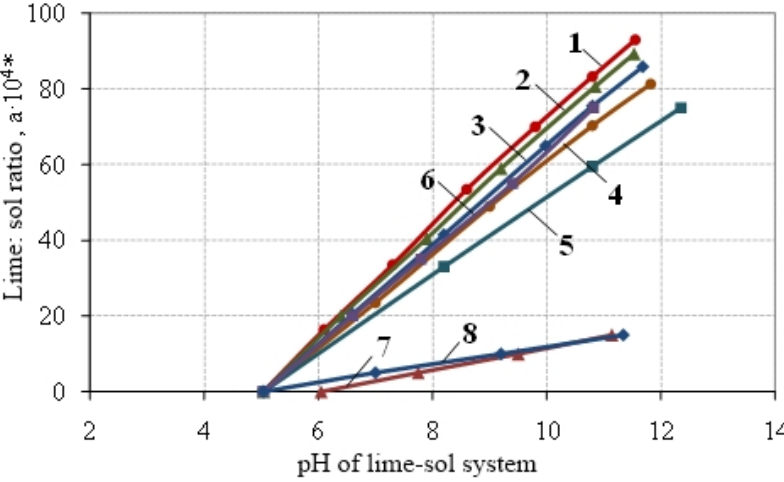
Figure 4. The kinetics of changes in the pH of the lime—sol system, depending on the ratio of lime: sol and the aging period of silica sol: 1—1 day; 2—5 days; 3—10 days; 4—15 days; 5—19 days;.6—stabilized sol; 7—Aerosil; 8—Aerosil heated. Note. * the ratio of the mass of lime to the mass of 2% silicic acid sol is given along the y ‐ axis.